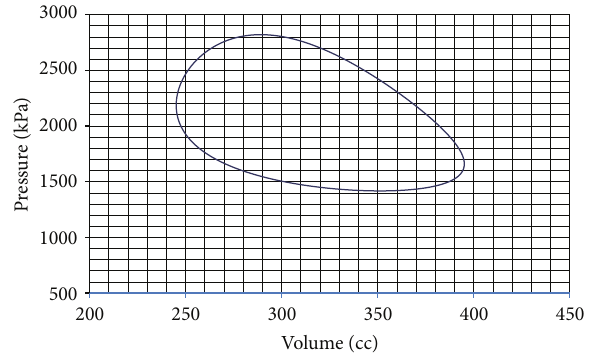
Figure 9: Changing of the total volume versus the crank angle for Stirling engine.